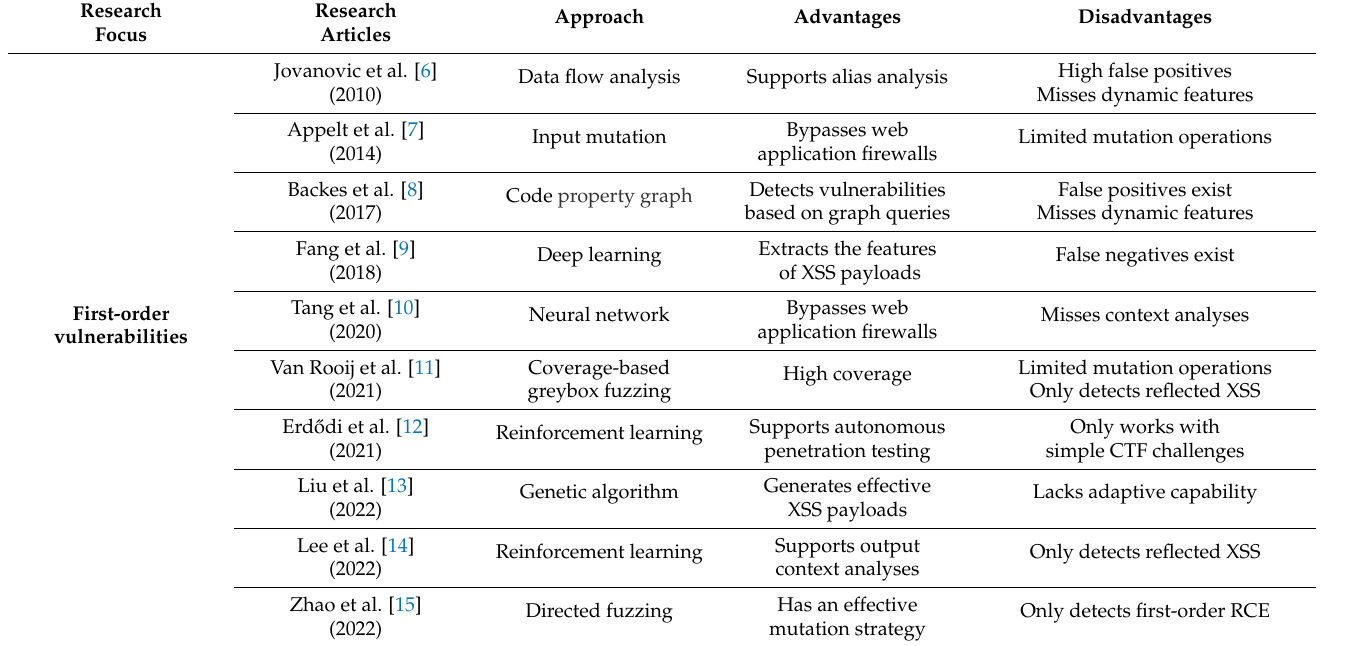
Table 1. Summary of related